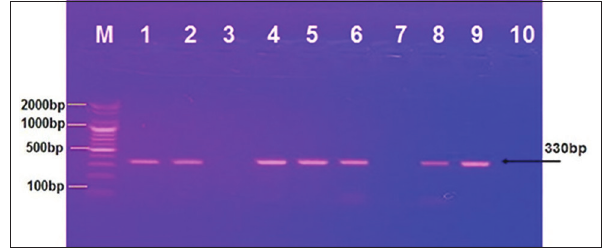
Figure-1: Agarose gel electrophoresis; positive bands of universal foot-and-mouth disease virus in samples 1, 2, 4, 5, 6, 8, and 9.